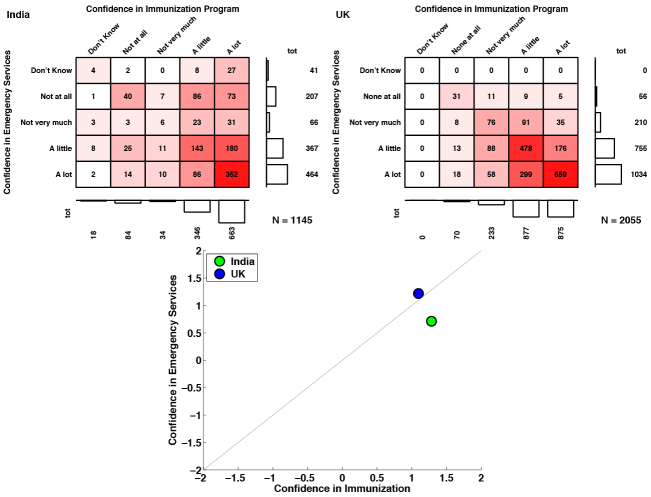

Fig. 7: Confidence in Immunisation Programme and Emergency Services
These contingency tables illustrate the varying association between confidence in immunisation programmes and confidence in emergency services in India and the UK.